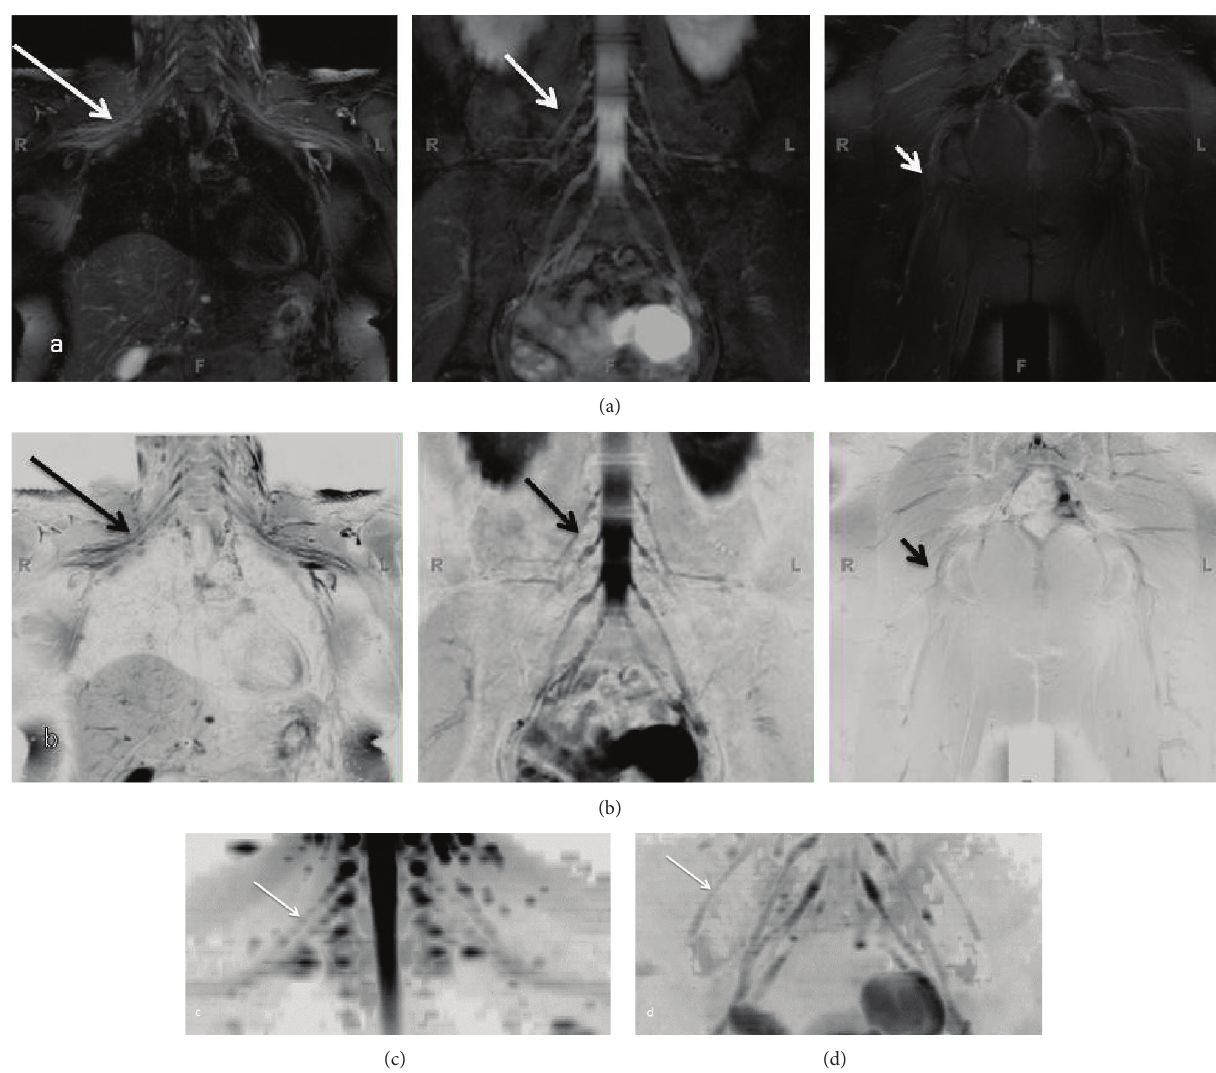
Figure 12: (a), (b) Whole body MRN: Coronal MIP reconstructions from 3D STIR SPACE sequence ((a) conventional window setting; (b) inverted window setting) show the normal appearance of bilateral brachial plexus (large arrows), LS plexus (medium arrows), and sciatic nerves (small arrows). (c), (d) Whole body MRN: Coronal MIP reconstructions (inverted grey scale contrast) from single shot DTI sequence ( 𝑏 values 0, 600s/mm 2 , 20 directions) of the brachial plexus (c) and LS plexus